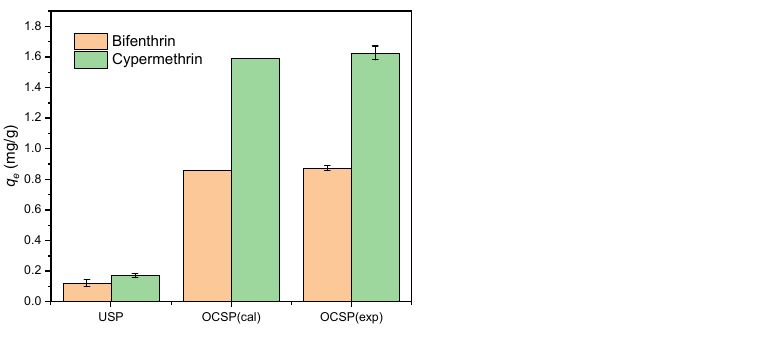
Figure 2. Adsorption of pyrethroids by different adsorbents (OCSP(cal) is calculated from the optimization model; OCSP(exp) is the experimental data).